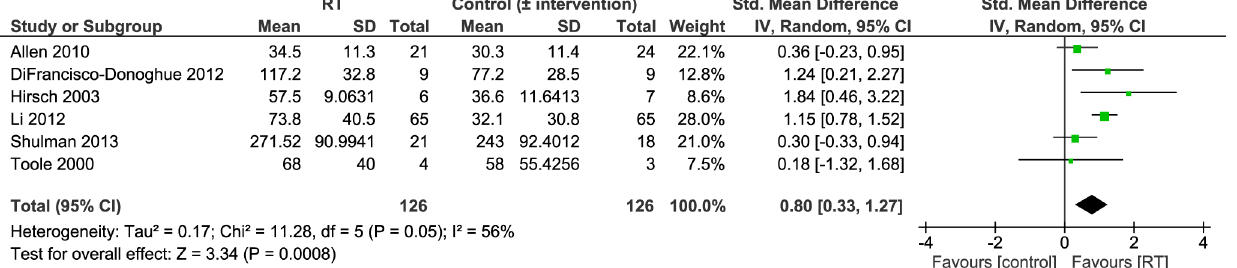
Fig 4. Primary analysis forest plot of comparison: RT vs. control-without/with-intervention, using post-intervention values, outcome: knee extension strength. CI = confidence interval; IV = inverse variance; SMD = standardized mean difference.